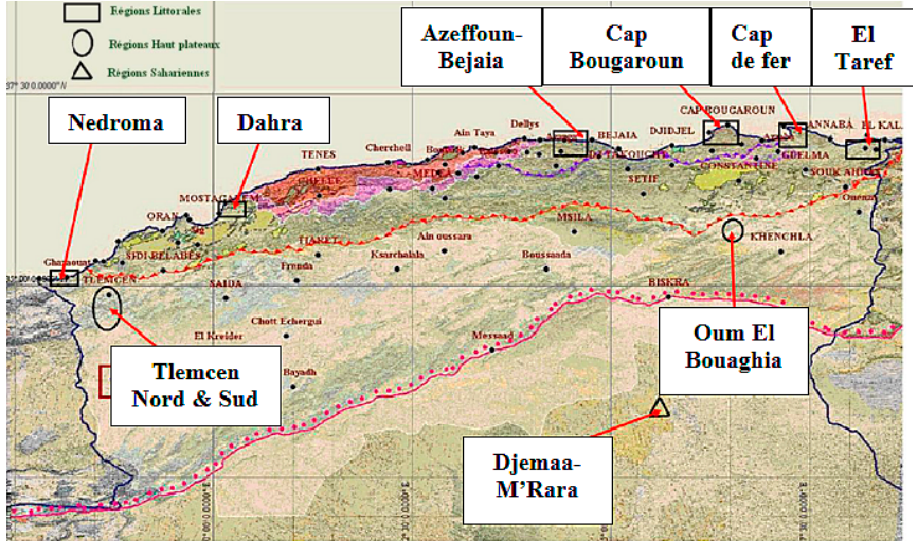
Figure 7. Distribution of the projected future nuclear power plant, NPP, in Algeria.